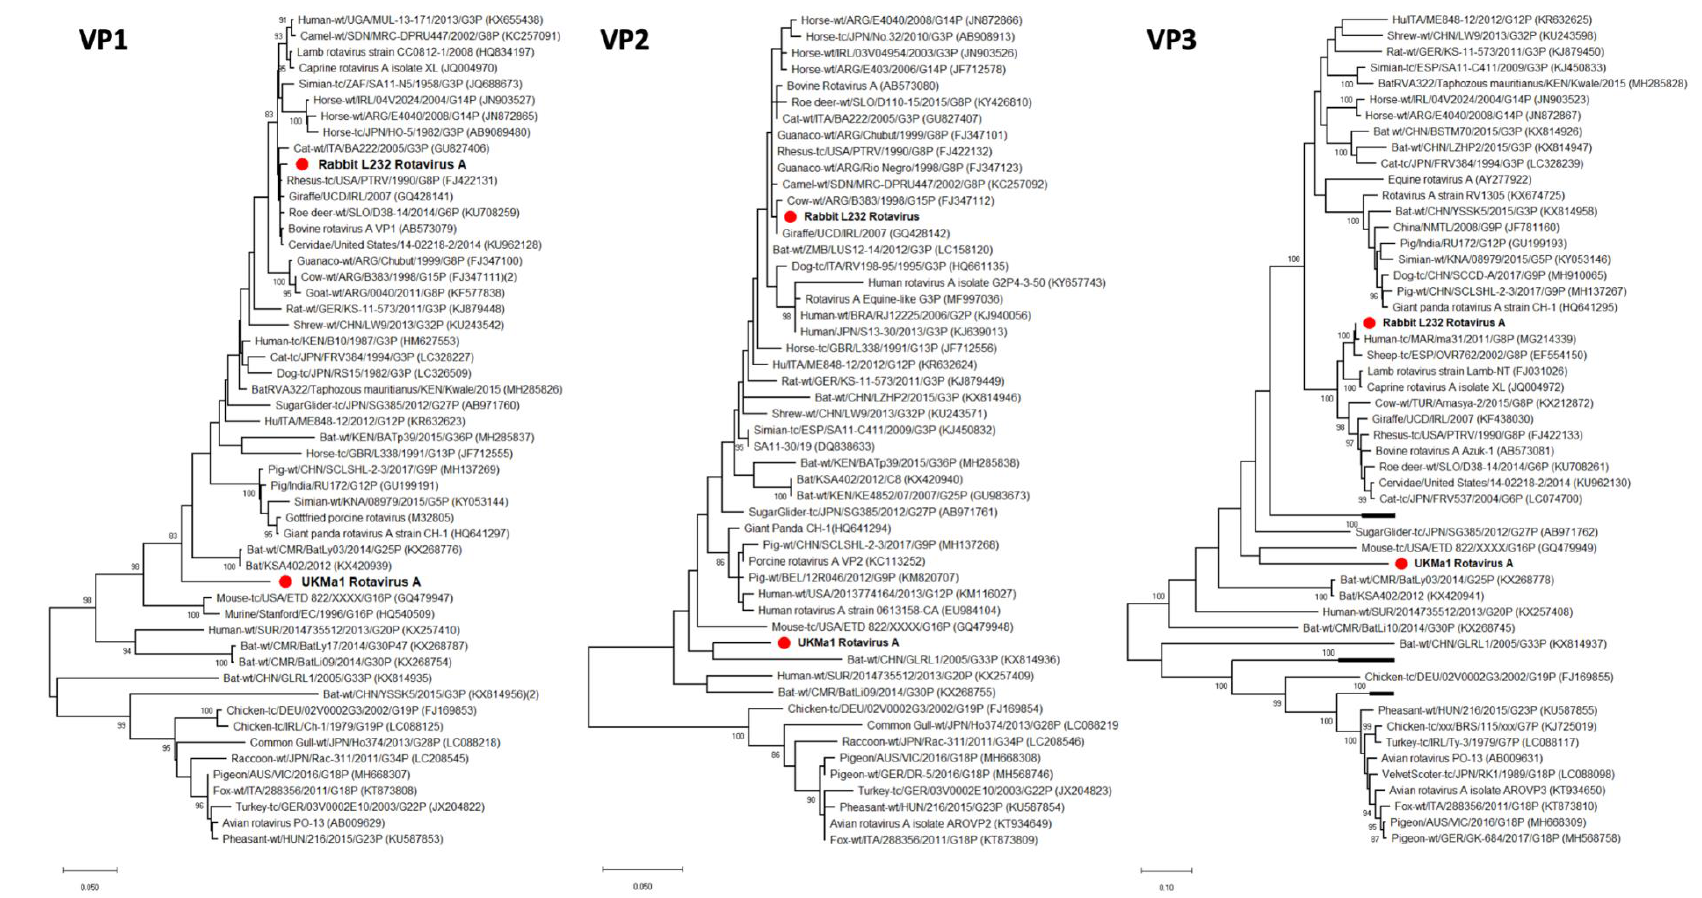
Figure 4. Phylogenetic relationships of the field vole and the rabbit rotavirus A based on the VP1, VP2 and VP3 segment. The trees represent maximum likelihood phylogenetic analyses of rotavirus A partial VP1 (648 aa), VP2 (329 aa) and VP3 (791 aa) segment sequences. The novel sequences obtained from the UK field vole UK Ma 1 and the French rabbit L232 were analyzed alongside reference sequences representing rotaviruses A from different host species. Reference sequences are indicated by their GenBank accession numbers. Branch lengths are drawn to a scale of amino acid substitutions per site. Numbers above individual branches indicate bootstrap support; only values >80% are shown. The novel rotaviruses A are marked with a red dot. For clarity, some viral clades have been collapsed.